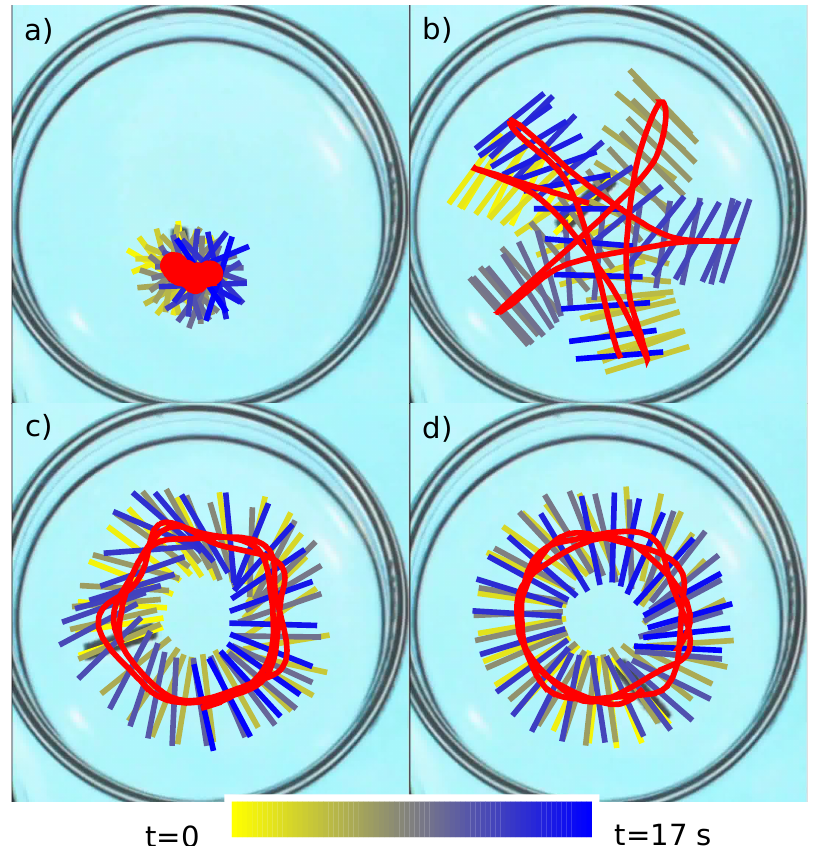
Figure 16. A few modes of the motion of a 1 cm-long rod made of 10% polypropylene, 45% camphene, and 45% camphor in a Petri dish with a diameter of 5 cm. The red curve marks the 17 s-long evolution of the rod center. The lines indicate the rod orientation. Time is indicated by the line color as defined by the bar below the figure. The time evolutions shown in Sub-figures ( a – d ) start 72 s, 240 s, 920 s, and 1200 s after the rod was placed on the water